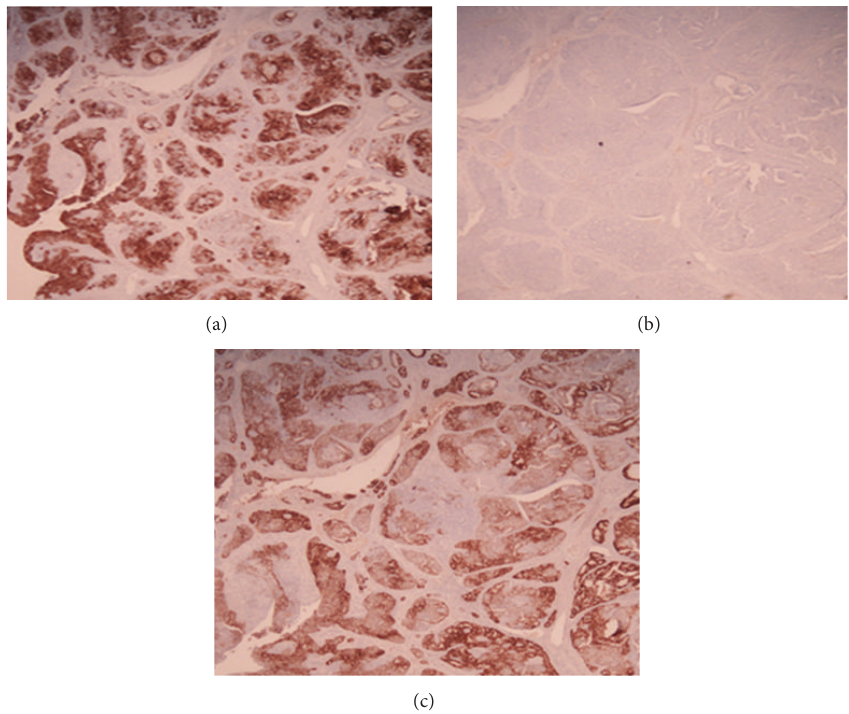
Figure 6: Immunohistochemistry: (a) (2x) tumor cells are positive for CK7 on the epithelioid components; (b) (2x) tumor cells show no expression for CK20; (c) (2x) tumor cells show strong diffuse expression for estrogen receptor (this immunohistochemical pattern is not consistent with colorectal primaries, but rather with m¨ullerian-derived